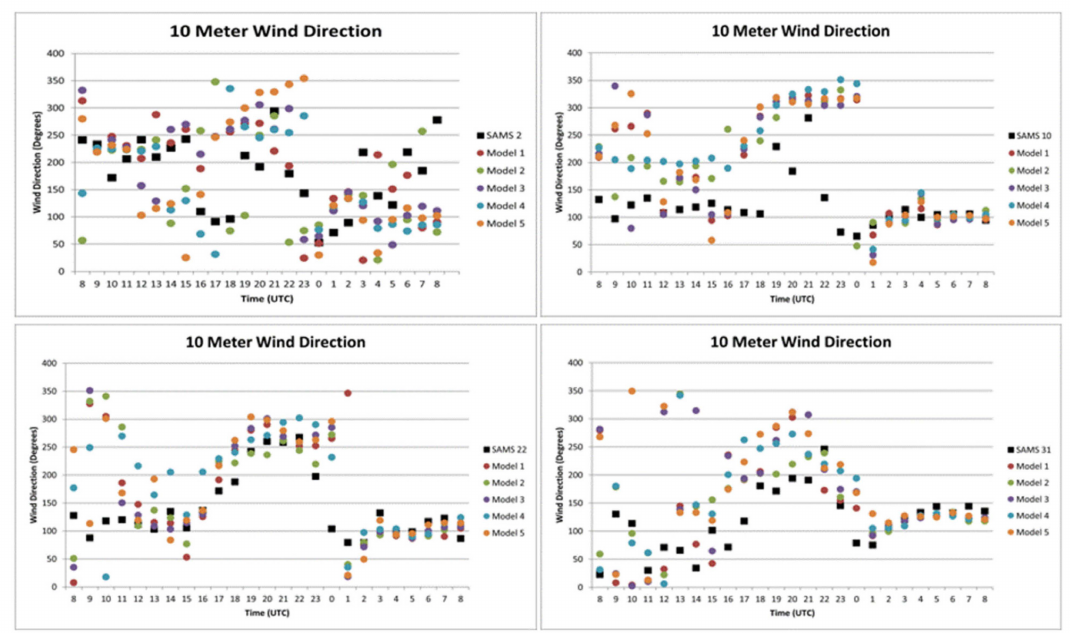
Figure 11. Observed 10 m AGL surface wind direction ( ◦ ) compared with model-simulated 10 m AGL surface wind direction ( ◦ ) for the different experiments across IOP6 at several different SAMS off-playa sites shown in Figure 1. Top left to bottom right: Sites 2, 10, 22, and